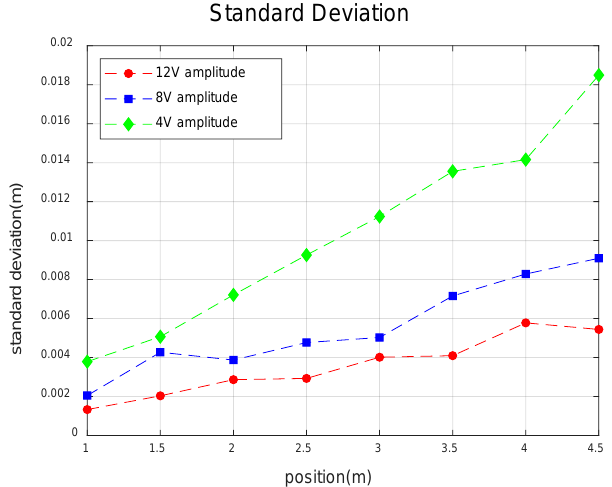
Figure 8. Standard deviation for each modulation voltage amplitude.